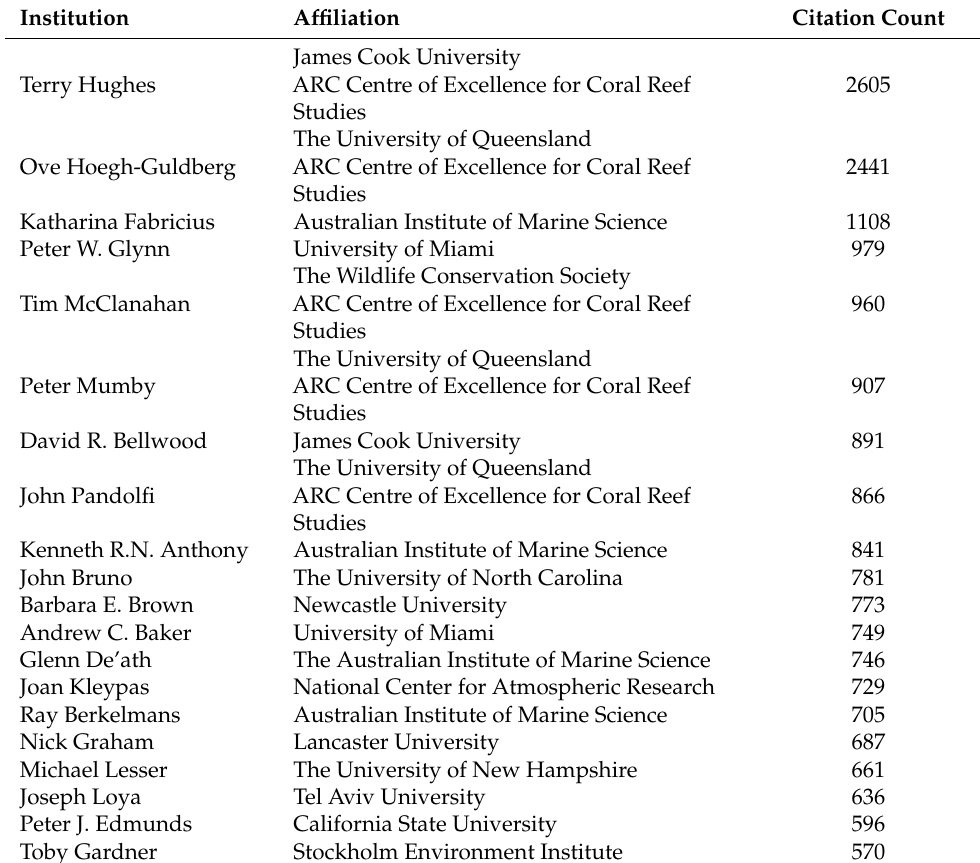
Table 3. Top 20 authors in the field of coral reef and climate